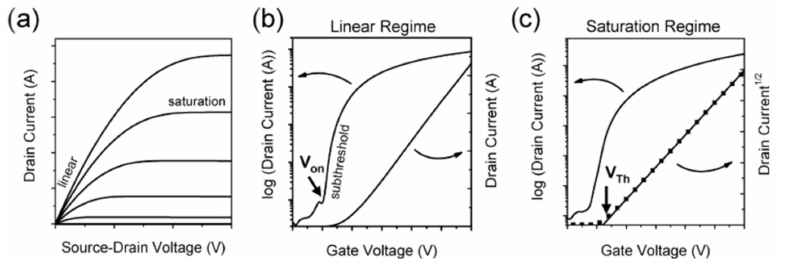
Figure 5. A representative current-voltage characteristics, ( a ) output curve, ( b ) transfer curve in linear regime, and ( c ) in saturation regime. Reprinted with permission from ref. [8]. Copyright 2007 American Chemical